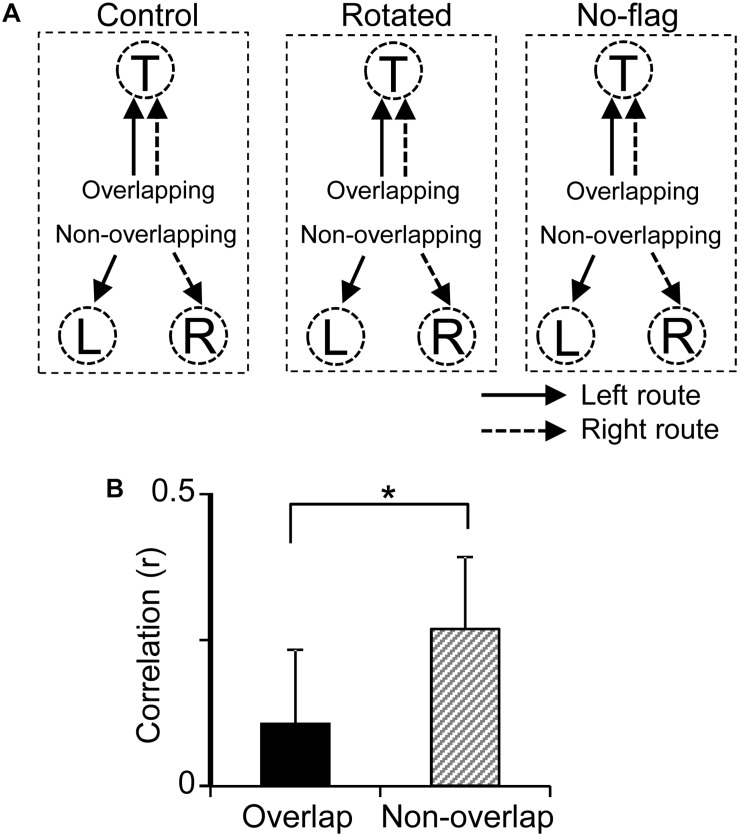
Representation of the overlapping and non-overlapping path segments by pre-reward activity of the reward-related neurons across the VN tasks. (A) Schematic illustration of overlapping and non-overlapping path conditions in the three VN tasks. (B) Comparison of mean correlation coefficients across the six path segments between the overlapping and non-overlapping path conditions. ∗p < 0.05.